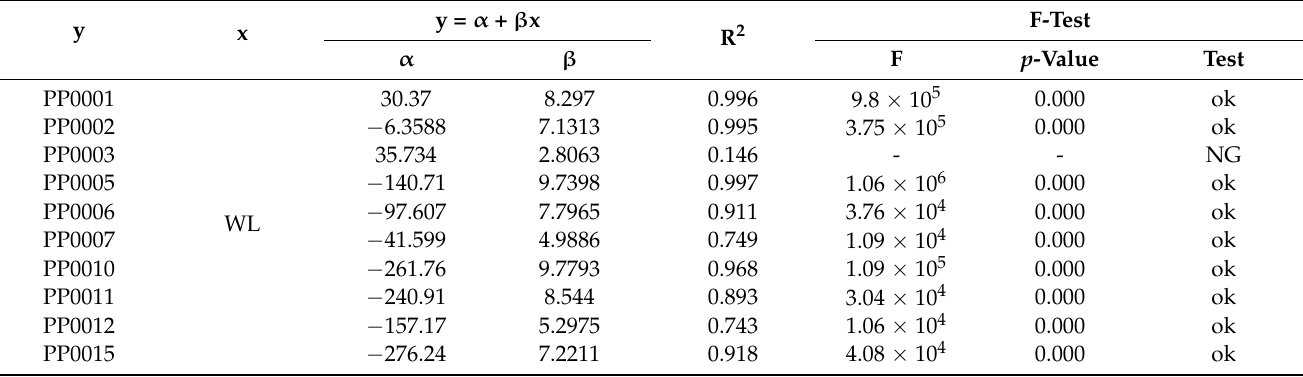
Table 5. Regression analysis between water level and porewater